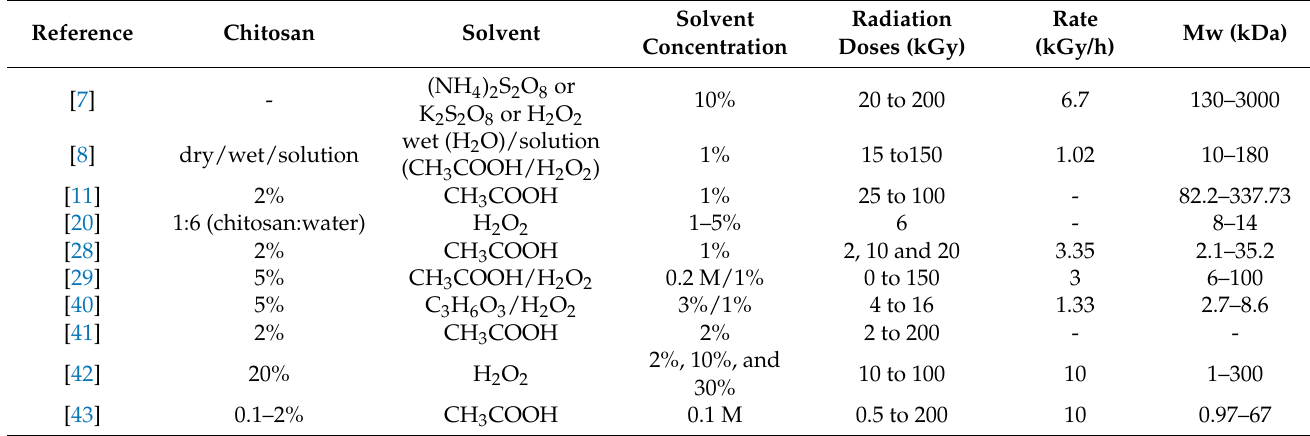
Table 2. Parameters of chitosan hydrolysis by gamma